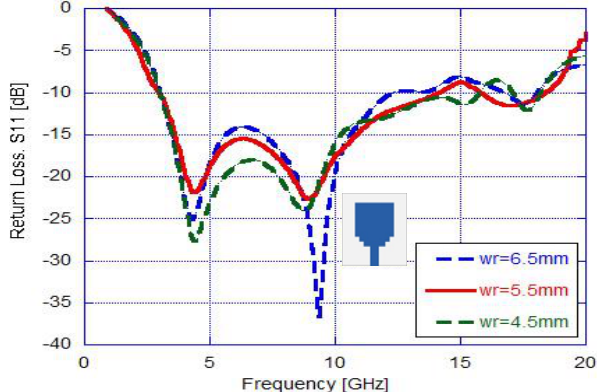
Fig. 3 Simulated return loss, S